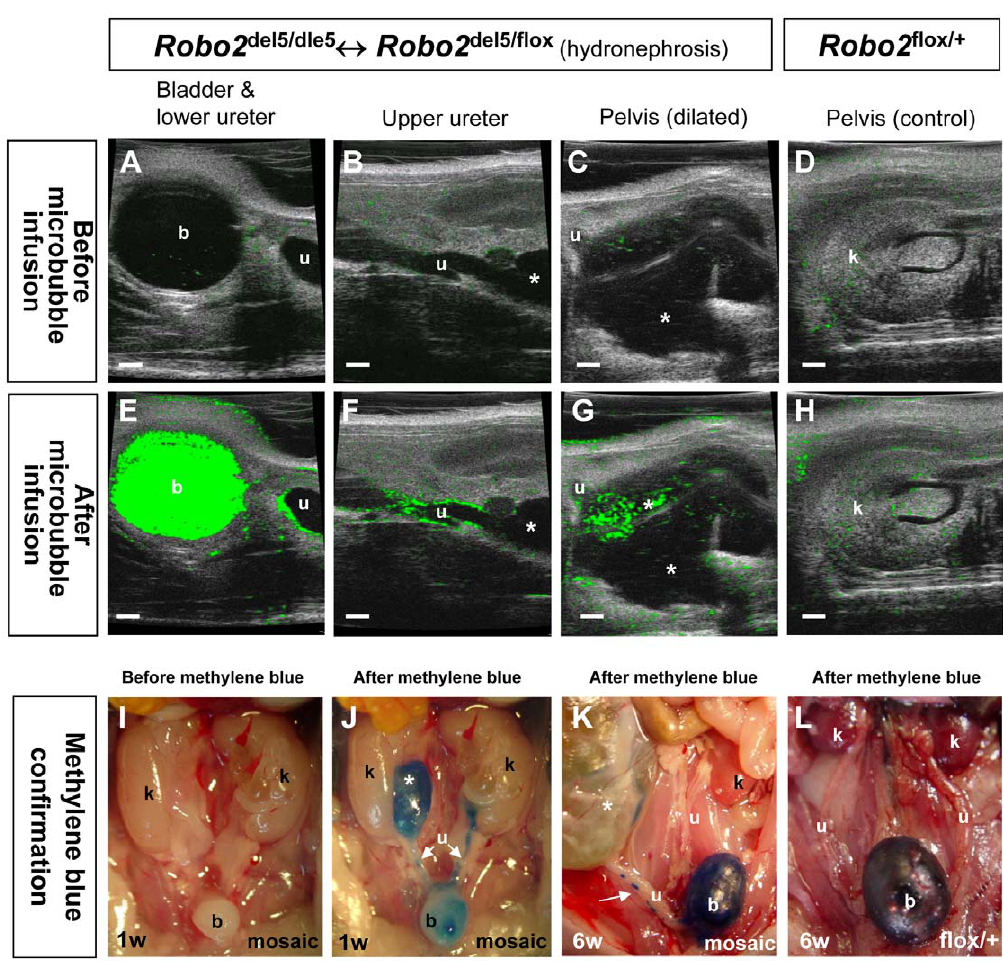
Figure 4. Hydronephrosis in Robo2 mosaic mice is caused by high-grade VUR. ( A – D ) Ultrasonographic images (green-scale under contrast- mode) depicted the urinary tract system and hydronephrosis (asterisk in C) in a Robo2 mosaic mouse (A–C) and the kidney pelvis region of a Robo2 flox/ + control (D) before infusion of microbubble ultrasound contrast agent into the mouse bladder. Some background green signals were also seen in the green-scale setting. ( E – G ) Ultrasonographic images (green-scale under contrast-mode) after microbubble contrast agent infusion showing the flow of microbubble (strong and fresh green signals) inside the same urinary tract system of the Robo2 mosaic mouse after infusion of microbubble into the bladder. The green color enhanced microbubble was refluxed into the renal pelvis (asterisks in G; also see Video S3) through the ureter (F). Only background green signals were seen in the Robo2 flox/ + control ( H ) without reflux. ( I – K ) Methylene blue cystogram was used to confirm reflux phenotype in an one week old Robo2 mosaic mouse (I,J) and a six weeks old Robo2 mosaic mutant mouse (K) showing retrograde flow of methylene blue into the renal pelvis (asterisks) through the ureter (white arrows in J,K). ( L ) A six weeks old wild-type control with methylene blue inside the bladder without reflux. Scale bars, 1.0 mm. Abbreviation: b, urinary bladder; k, kidney; u, ureter. Robo2 del5/del5 homozygous embryos (Fig. 6K), but not in wild-type controls (Fig. 6L). Because normal ureteral smooth muscle development is critical for ureterovesical junction formation and bladder trigone structure [34], we next examined the morphology of ureteral smooth muscle in early Robo2 del5/del5 homozygous embryos before ureter dilatation by triple and dual immunohis- tochemistry staining. Using anti-smooth muscle a actin antibody (a ureter smooth muscle marker), E-cadherin (a marker for ureter urothelium) and lectin Dolichos Biflorus (DBA, another marker for ureter urothelium), we found normal looking urothelium but disarrangement and reduced abundance of ureteral smooth muscle in three E14.5 Robo2 del5/del5 homozygous embryos (Fig. 6M,N and Figure S8) before any ureteral dilatation or hydronephrosis. These results suggest that Robo2 signaling may be necessary for the intercalation of ureteric smooth muscle into the bladder trigone to form a normal ureterovesical junction [34].